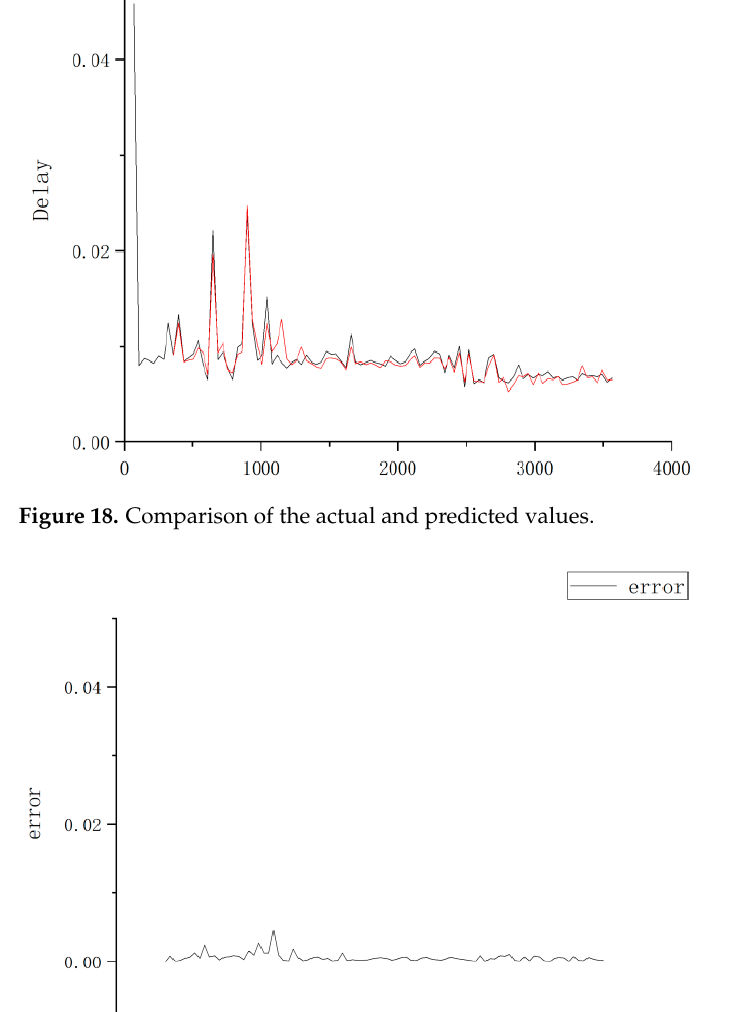
Figure 19. Error between the actual and predicted Figure 19. E rror between the actual and predicted values.